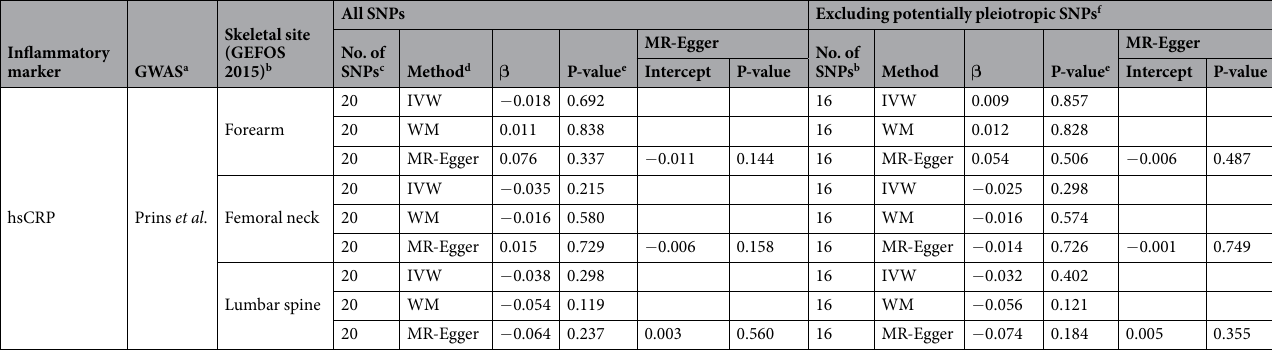
Table 1. Estimates of the effects of hsCRP on bone mineral density (in standard deviations) at forearm, femoral neck, and lumbar spine provided by GEFOS. a In the MR study of Prins et al ., hsCRP was analysed on a natural log scale in mg/L. b Bone mineral density was measured as the standard deviation (SD) from the healthy young adult reference. c Number of SNPs included in the analysis of one markers at different skeletal sites may differ, because particular SNPs may not be available in GEFOS of specific skeletal site. d Inverse-variance weighted (IVW), weighted median (WM), and MR-Egger were performed for testing the robustness of the association; WM and MR-Egger are only feasible with more than two SNPs. e Associations with a p-value smaller than 0.0125 were in bold. f SNPs with potentially pleiotropic effects related to obesity were excluded from the sensitivity analysis, including rs1260326 ( GCKR ), rs13233571 ( BCL7B ), rs2847281 ( PTPN2 ), and rs4129267 ( IL6R ) for